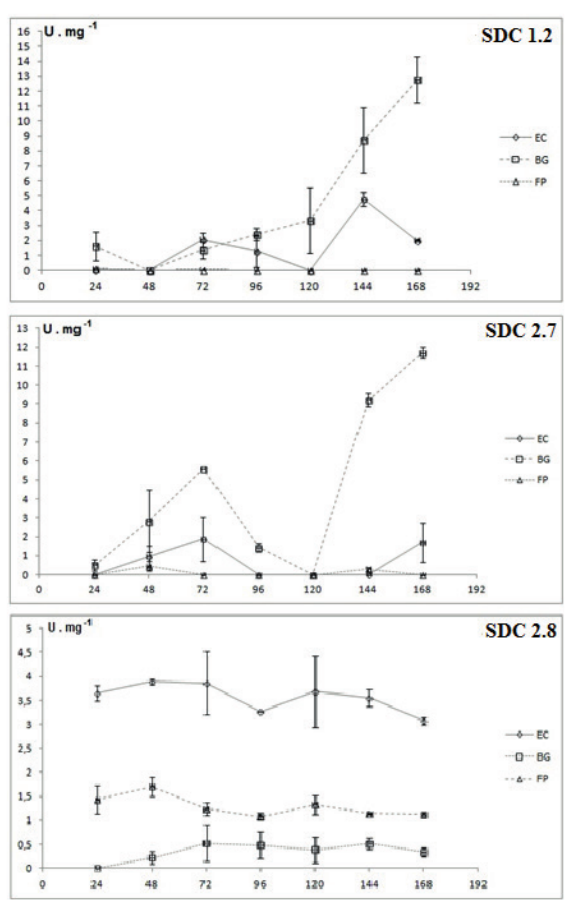
Figure 1 - enzymatic kinetics of the cellulolytic complex (eC = endoglucanase, BG = β-glucosidase and FP = cellulose total) from the three wild type fungal strains Aspergillus ustus (SDC 1.2), Talaromyces brunneus (SDC 2.7) and Aspergillus sp. (CBMAI 1926- SDC 2.8) grown in submerged fermentation using microcrystalline cellulose as sole carbon